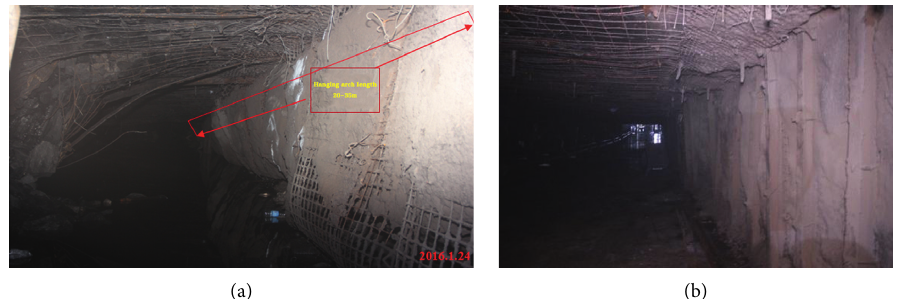
Figure 19: Effect diagram of the roadway (a) before and (b) after